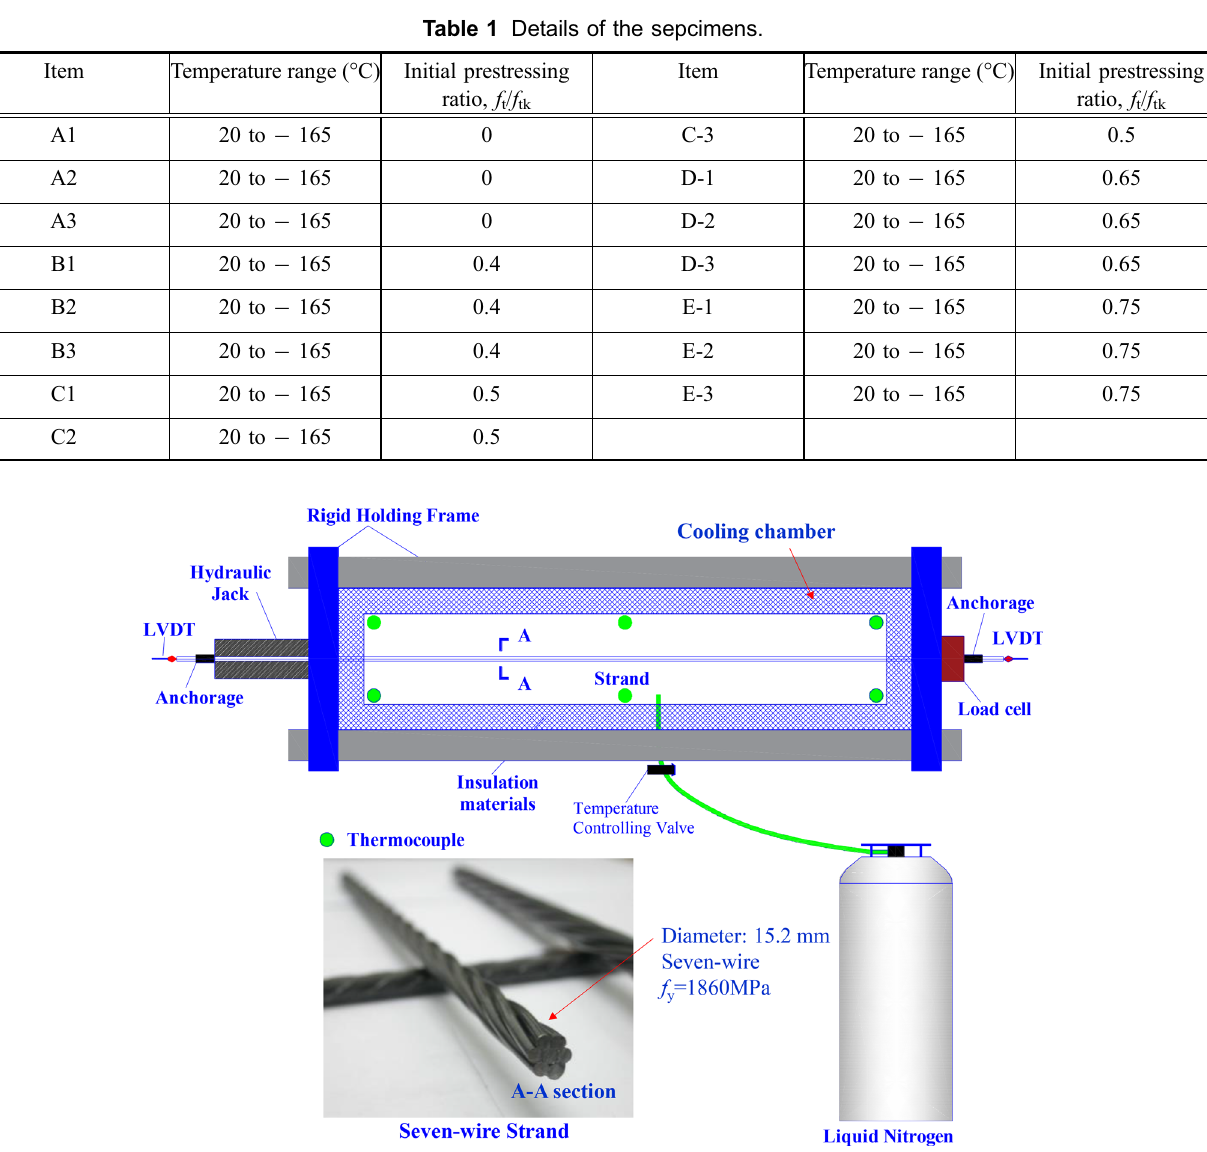
Fig. 1 Test setup on thermal expansion of steel strand under different pre-stressing levels and low temperatures.